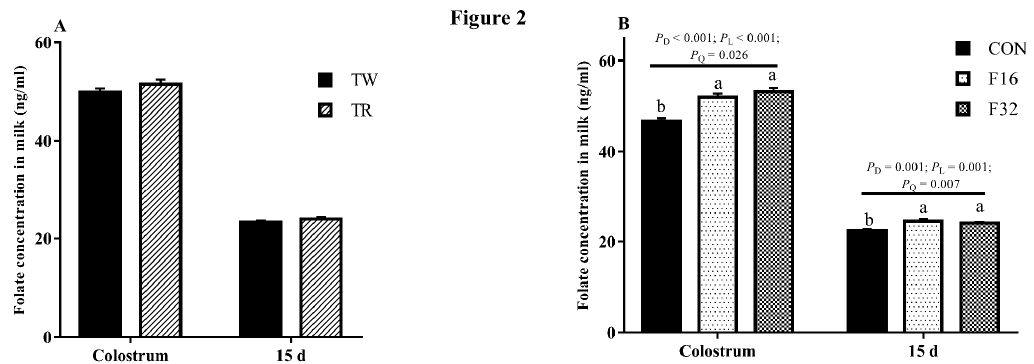
Figure 2. E ff ect of litter size ( A ) and FA levels ( B ) on the folate concentrations in milk. Data are means ± SEM. TW, twin born; TR, triplet born; CON, F16 and F32, ewes fed 0, 16, or 32 mg · (kg.DM) − 1 FA in the basal diet, respectively. P D , P value of diet FA supplementation; P L , P value of liner e ff ect; P Q , P value of quadratic e ff ect.